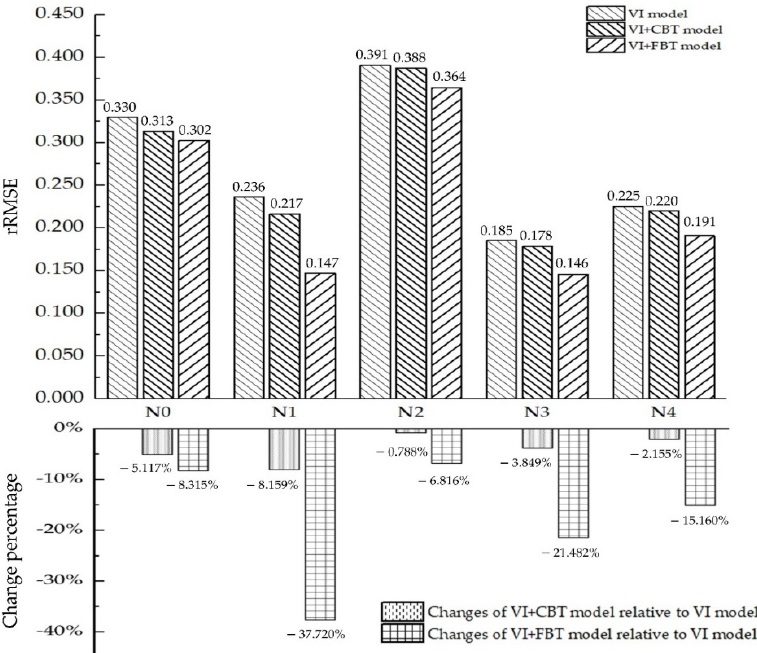
Figure 9. The rRMSEs of estimated AGB using VI model, VI+CBT model, and VI+FBT model under different nitrogen levels and the percentage changes of VI+CBT model and VI+FBT model relative to VI model (note: the presented values were rounded to three decimals for the sake of simplicity).